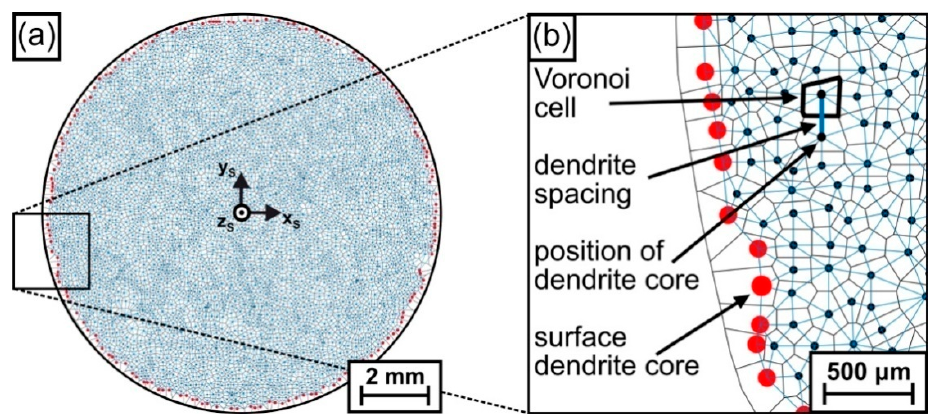
Figure 7. Characterization of microstructures using Voronoi tessellation [67,68]. ( a ) Overview image. ( b ) All dendrite positions in the spherical disk are represented by dark blue points. The red points mark the position of dendrites on the outer rim of the sample. For details, see text.